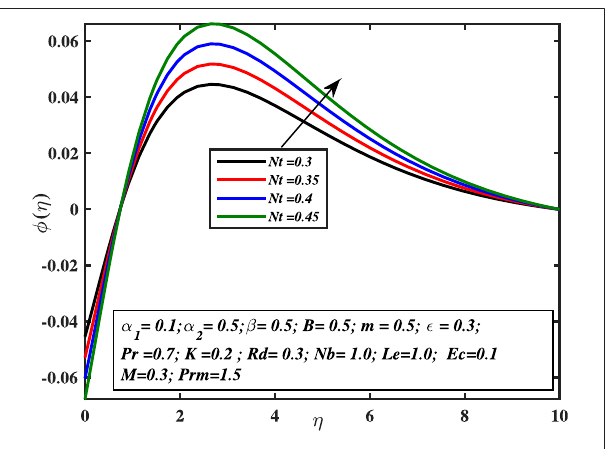
FIGURE 11 | Impact of Rd on the θ ( η ) curve.